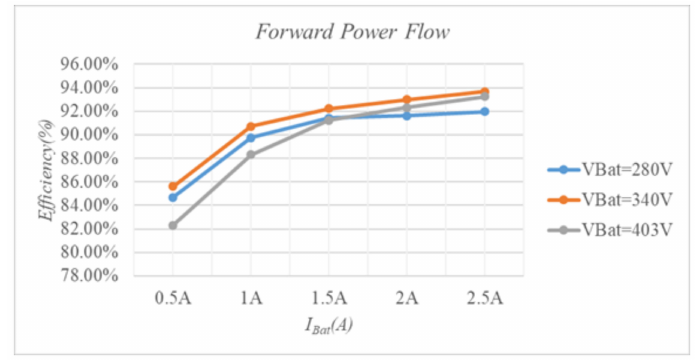
Figure 20. Conversion e ffi ciency curves for the forward charging mode.